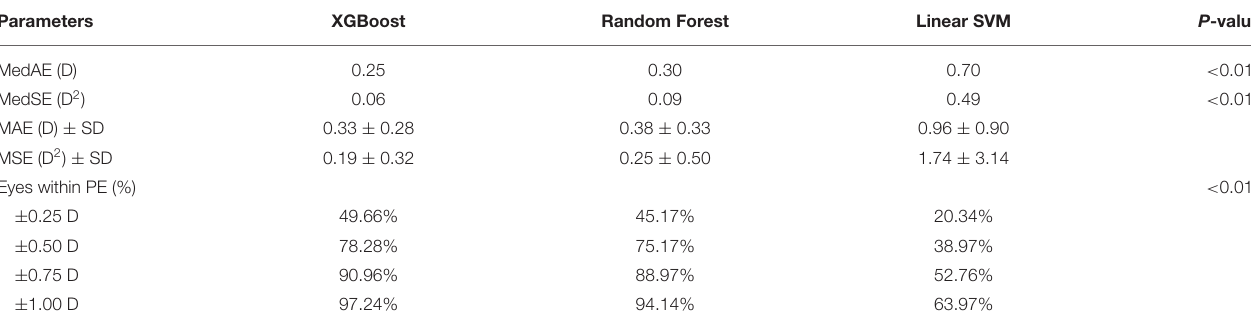
TABLE 2 | Comparison regression models including the XGBoost, Linear Support Vector Machine, and Random Forest using the internal test dataset. Parameters